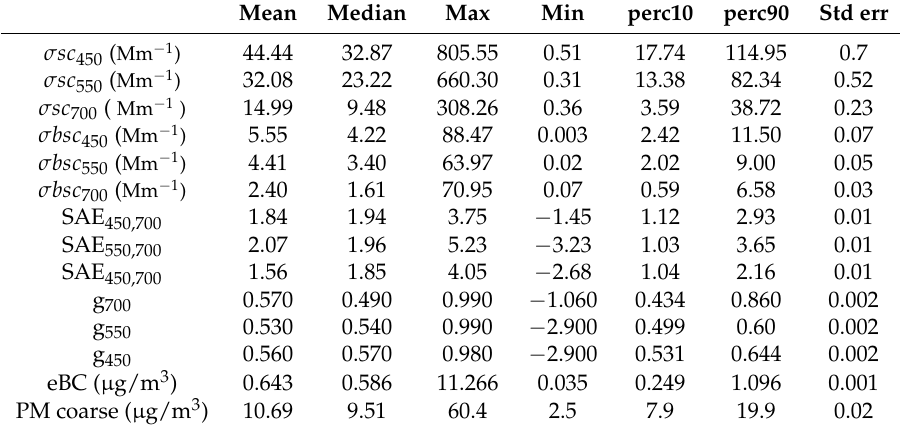
g), eBC and of the measured of PM coarse (from 1 day average), over the whole period analyzed, at LMT